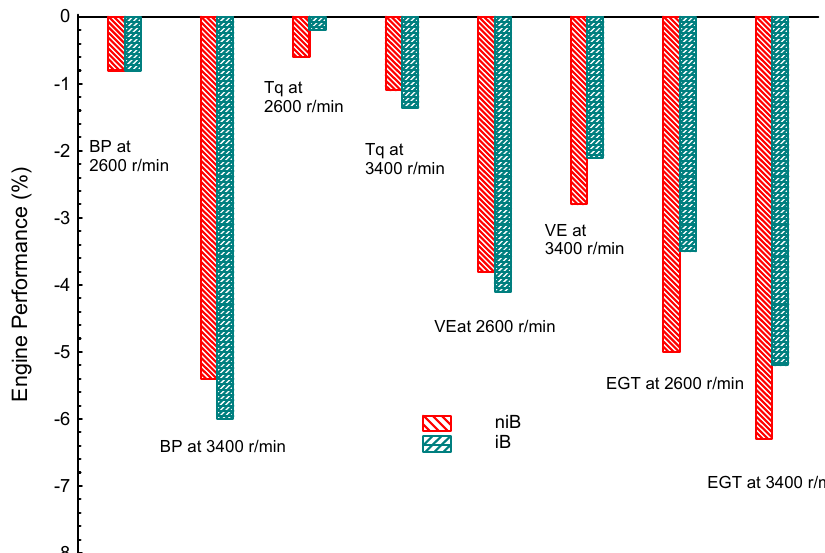
Figure 11. Comparison of brake power (BP), torque (Tq), volumetric efficiency (VE) and exhaust gas temperature (EGT) for i-butanol–gasoline blends (iB), n-butanol–i-butanol–gasoline blends (niB) and neat gasoline (baseline) at two different concentrations.